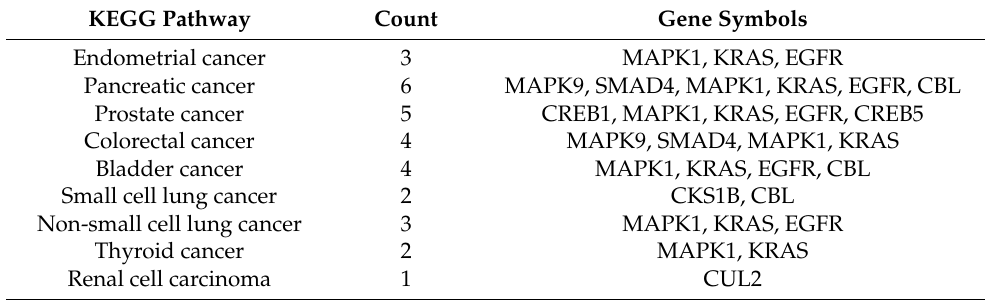
Table 7 lists the molecular pathways collected in the KEGG database and the genes involved. Moreover, MAPK9, MAPK1, KRAS, CBL, and EGFR are also involved in other molecular mechanisms active in cancer, such as choline metabolism, proteoglycan, and cen- tral carbon metabolism. Table 7. The genes known to be involved in cancer, from the KEGG database of molecular. KEGG Pathway Count Gene Symbols Endometrial cancer 3 MAPK1, KRAS, EGFR Pancreatic cancer 6 MAPK9, SMAD4, MAPK1, KRAS, EGFR, CBL Prostate cancer 5 CREB1, MAPK1, KRAS, EGFR, CREB5 Colorectal cancer 4 MAPK9, SMAD4, MAPK1, KRAS Bladder cancer 4 MAPK1, KRAS, EGFR, CBL Small cell lung cancer 2 CKS1B, CBL Non-small cell lung cancer 3 MAPK1, KRAS, EGFR Thyroid cancer 2 MAPK1, KRAS Renal cell carcinoma 1